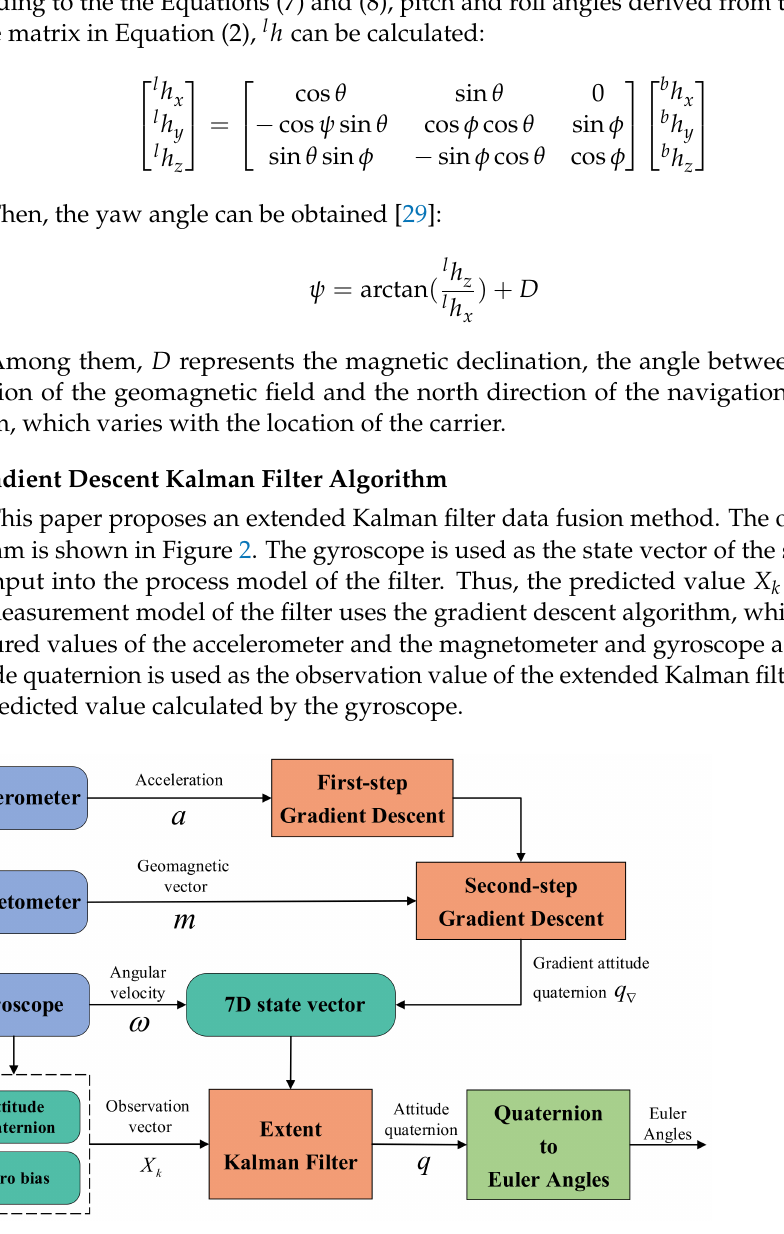
Figure 2. Block diagram of Kalman filter proposed in this